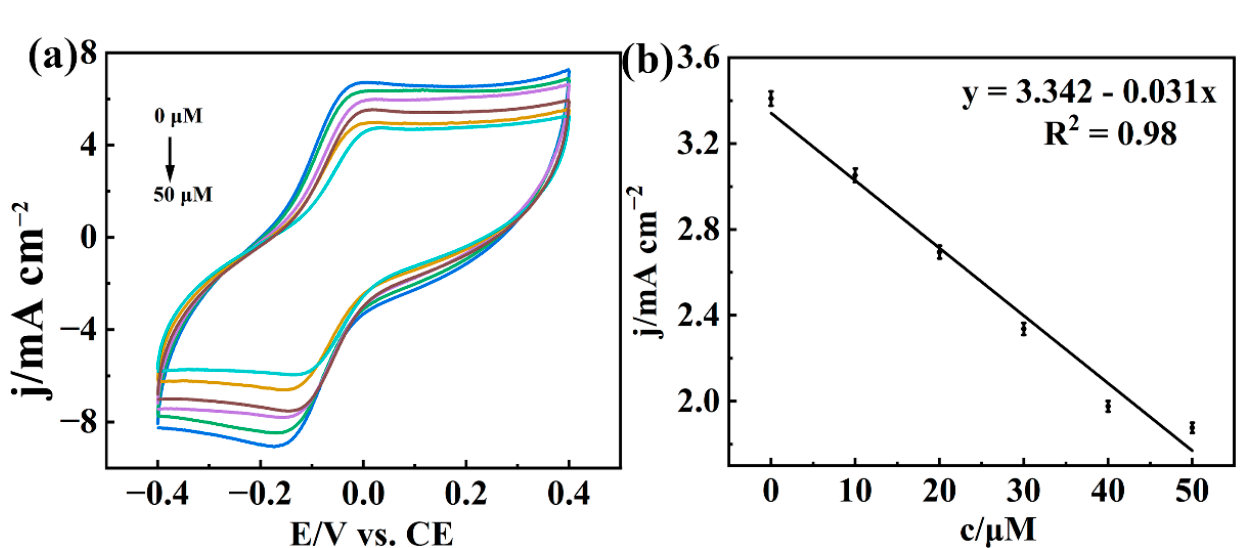
Figure 6. ( a ) CVs of AChE/COF DHNDA-BTH /portable paper-based electrode in 0.1 M KCl + 5.0 mM [Fe(CN)6] 3 − /4 − with carbaryl different concentrations. ( b ) Corresponding linear relationship curve.